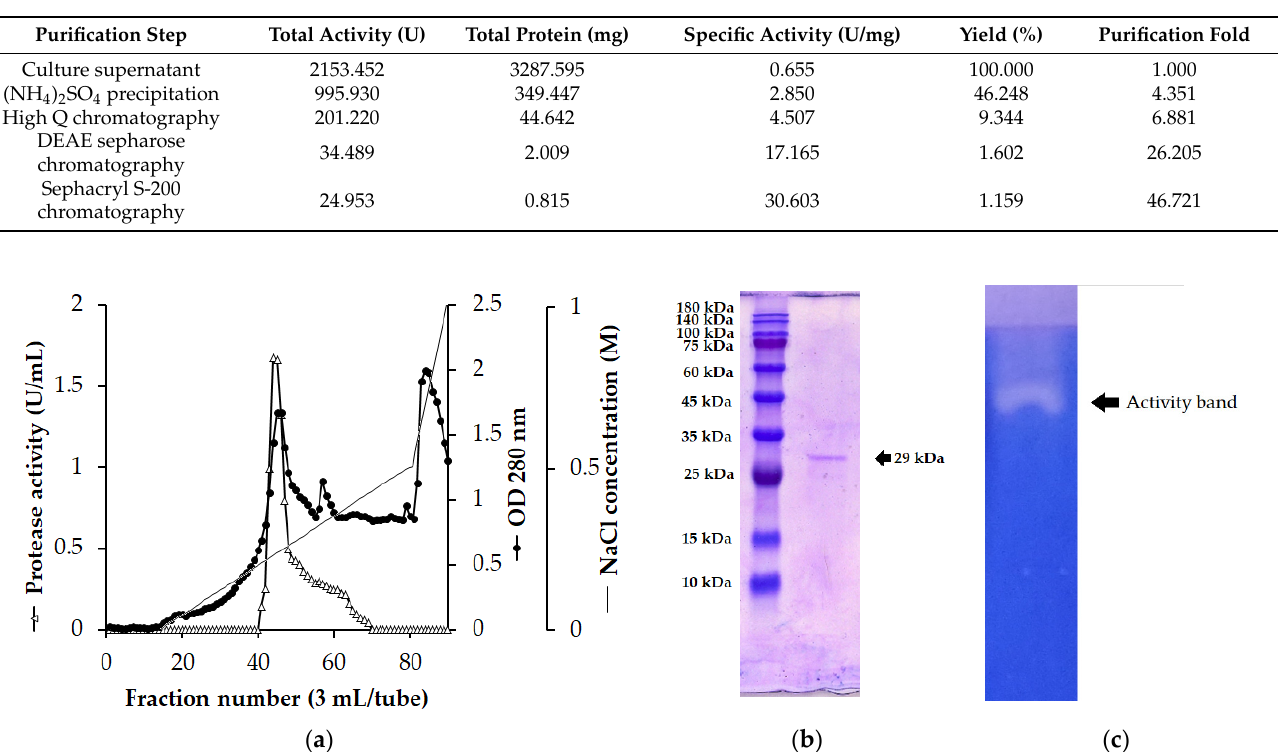
Table 4. Purification profile of P. elgii TKU051 protease.